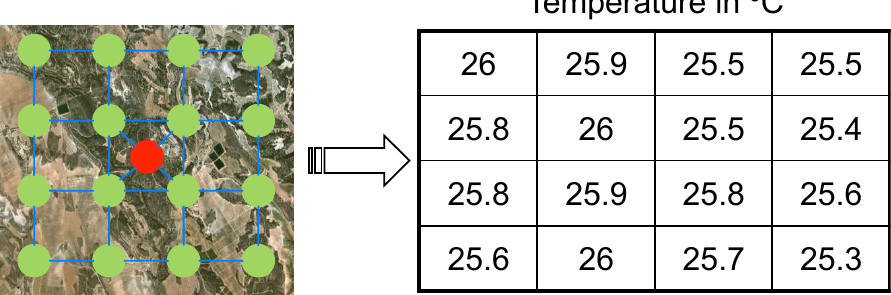
Figure 2. Wireless sensor network (WSN) measurements viewed as the components of a signal represented by a